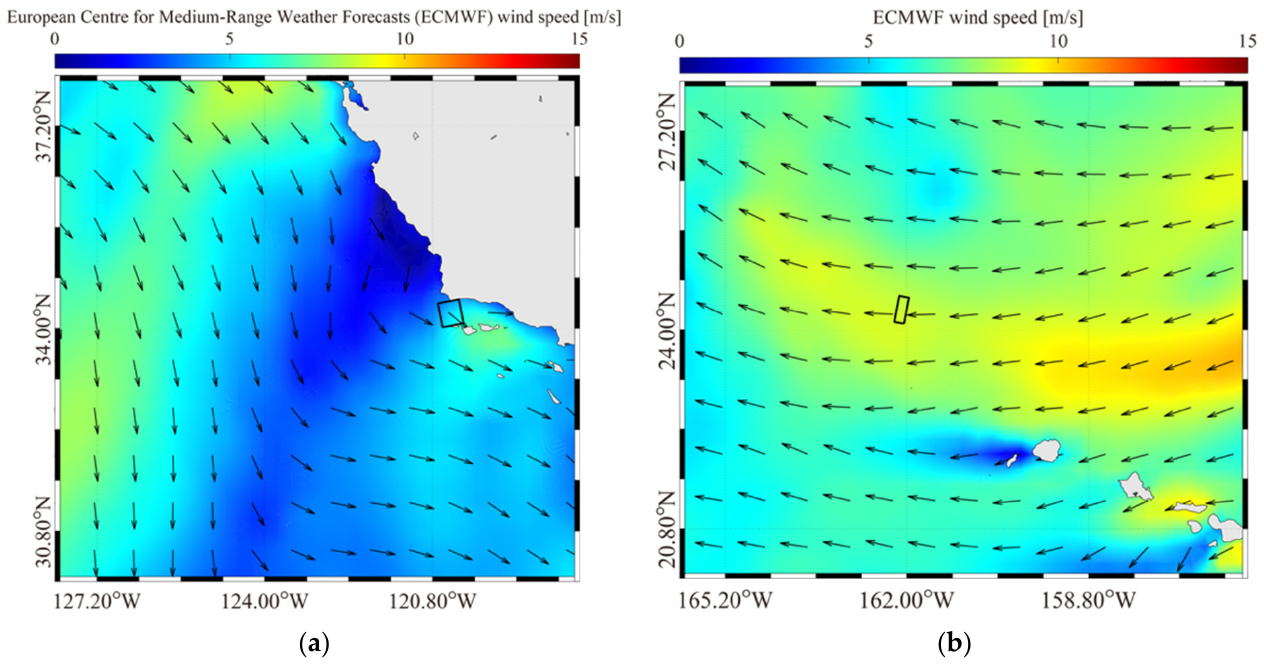
Figure 2. ( a ) The European Centre for Medium-Range Weather Forecasts (ECMWF) reanalysis data (ERA-5) wind map at 2:00 UTC on 5 May 2017; and ( b ) The ERA-5 wind map at 17:00 UTC on 3 August 2009. The black rectangle denotes the spatial coverage of two images in Figure 1.